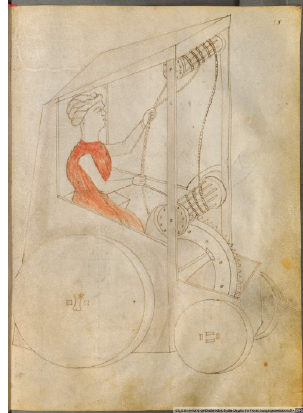
Figure 6. An automatic clock and calendar device